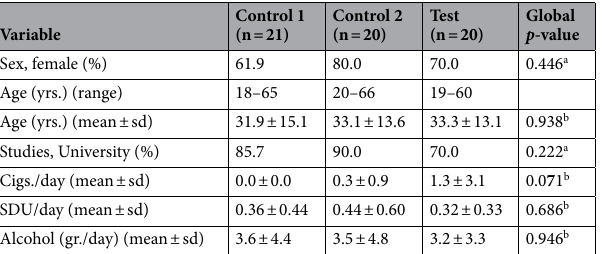
Table 1. Description of sociodemographic and habit-related variables in the study groups. SDU Standard Drink Unit. a Chi-square test, b ANOVA.